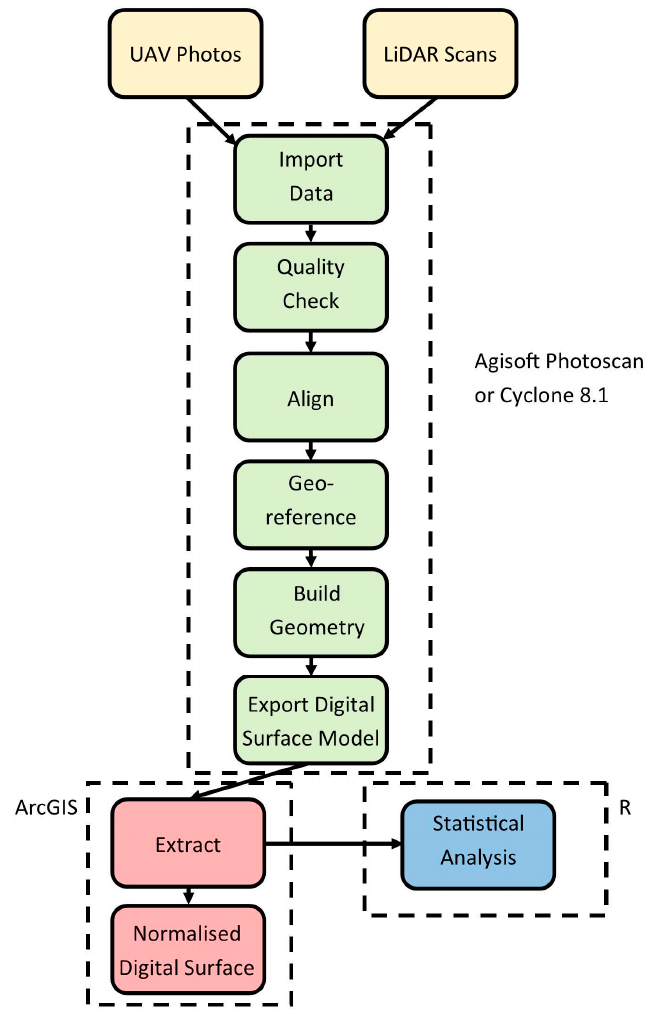
Table 4. Parameters of the UAV flights and Agisoft Photoscan processing used in the 2014 Pilot Study. Model resolution is the reported model resolution provide by Agisoft Photoscan.